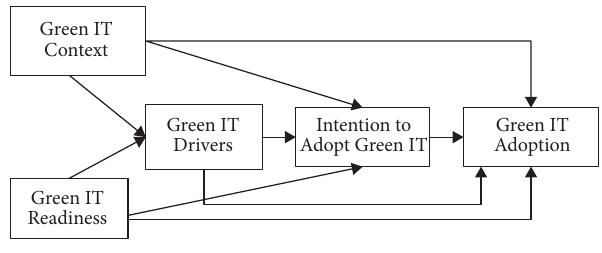
Figure 1: Basic GITAM framework